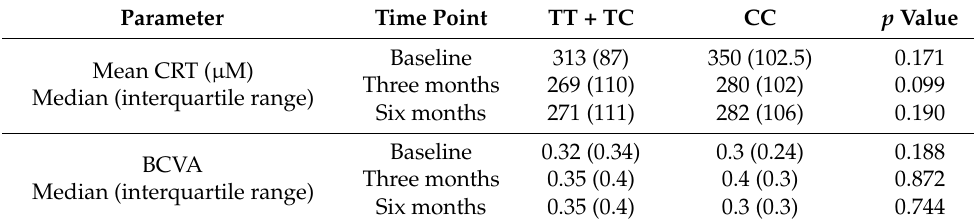
Table 7. CRT and BCVA associations with ABCA1 rs1883025